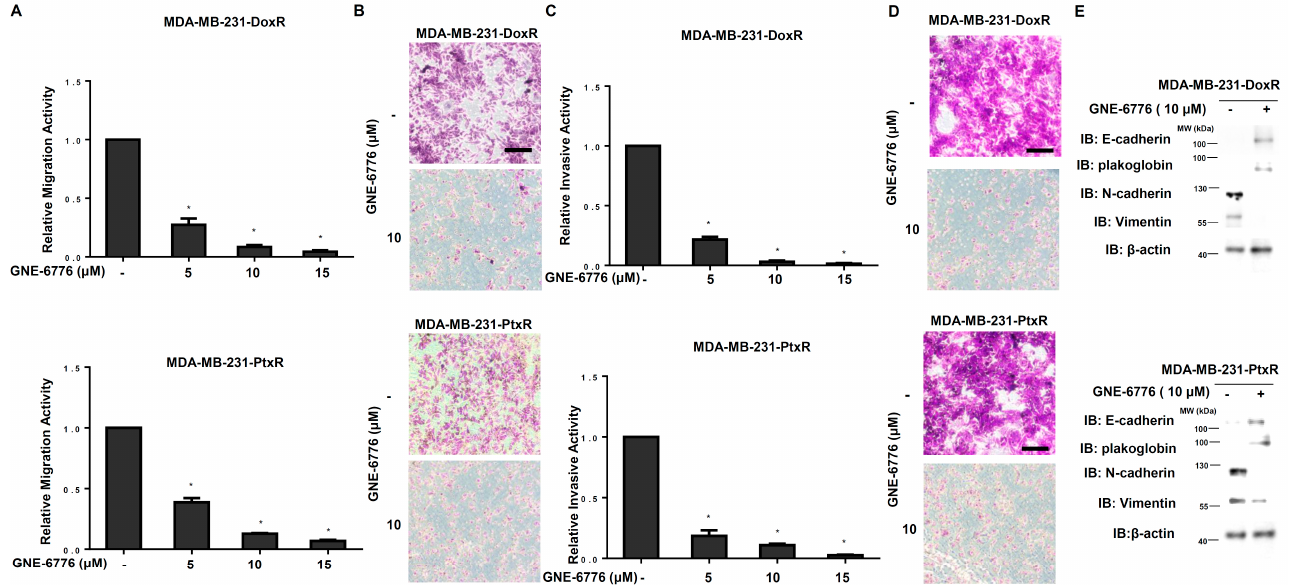
Figure 7. Effect of USP7 inhibitor on metastatic activity of chemoresistant TNBC. ( A ) Relative migration activity in MDA-MB-231-DoxR (upper) and MDA-MB-231-PtxR (lower) cells under serial doses of GNE-6776 by performing in vitro Transwell-dependent migration assays. ( B ) Images for migration activity of GNE-6776-treated MDA-MB-231-DoxR (upper) and MDA-MB-231-PtxR (lower) cells. ( C ) Relative invasive activity of MDA-MB-231-DoxR (upper) and MDA-MB-231-PtxR (lower) cells under serial doses of GNE-6776, using in vitro Transwell-dependent invasive assays. ( D ) Images for the invasive activity of GNE-6776-treated MDA-MB-231-DoxR (upper) and MDA-MB-231-PtxR (lower) cells. ( E ) Protein levels of EMT markers in MDA-MB-231-DoxR (upper) and MDA-MB-231-PtxR (lower) cells under serial doses of GNE-6776, by western blot analysis with specific antibodies. Data are represented as the mean ± SEM for biological triplicate experiments. * p < 0.05, compared with cells with steady concentration of doxorubicin and paclitaxel, respectively.